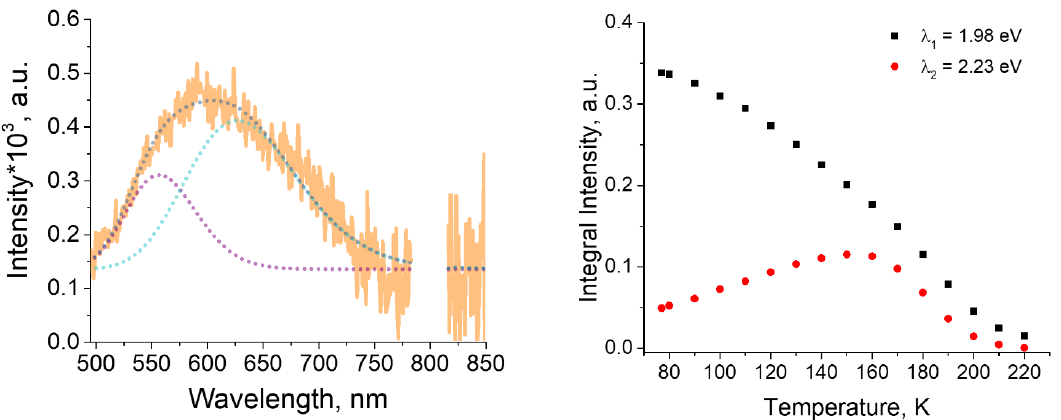
Figure 8. PL spectrum (λ ex = 400 nm) of 1 at 300 K with two Gauss approximation in direct energy units (λ 1 = 1.98 eV, λ 2 = 2.23 eV) ( left ); temperature dependence of the PL bands integral intensities (λ Ex = 400 nm) of 1 using two Gauss approximation (λ 1 = 1.98 eV, λ 2 = 2.23 eV) ( right ).